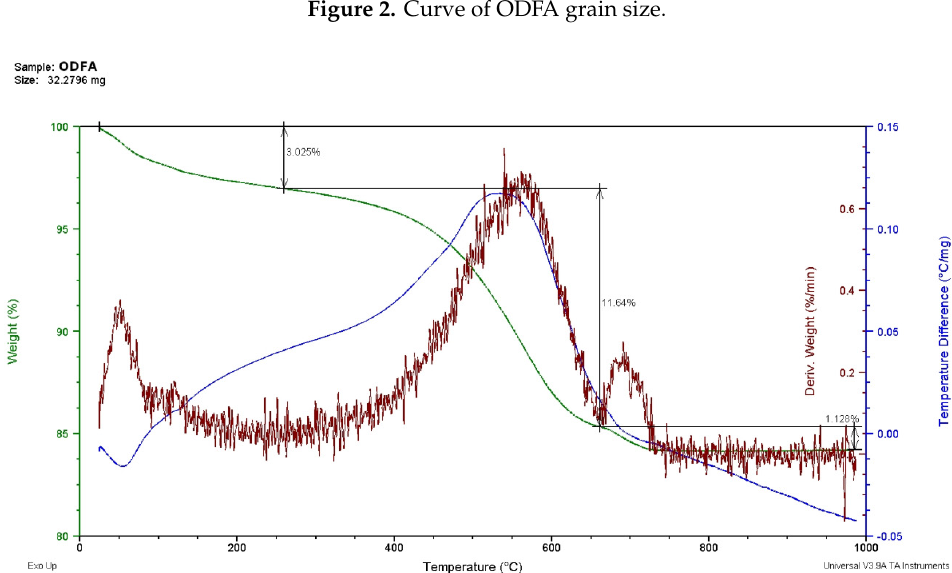
Figure 3. Thermal analysis—TG and DTA curves of ODFA; the green curve (TG) represents the change in mass of the sample in temperature function; the blue curve (TGA) represents the change of temperature of the sample in regard to the reference sample.